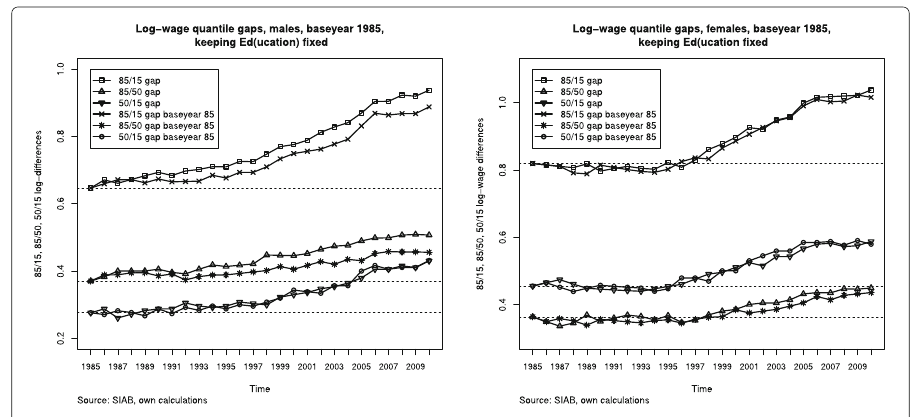
Fig. 10 Inequality development base year 1985, specification E (Education)